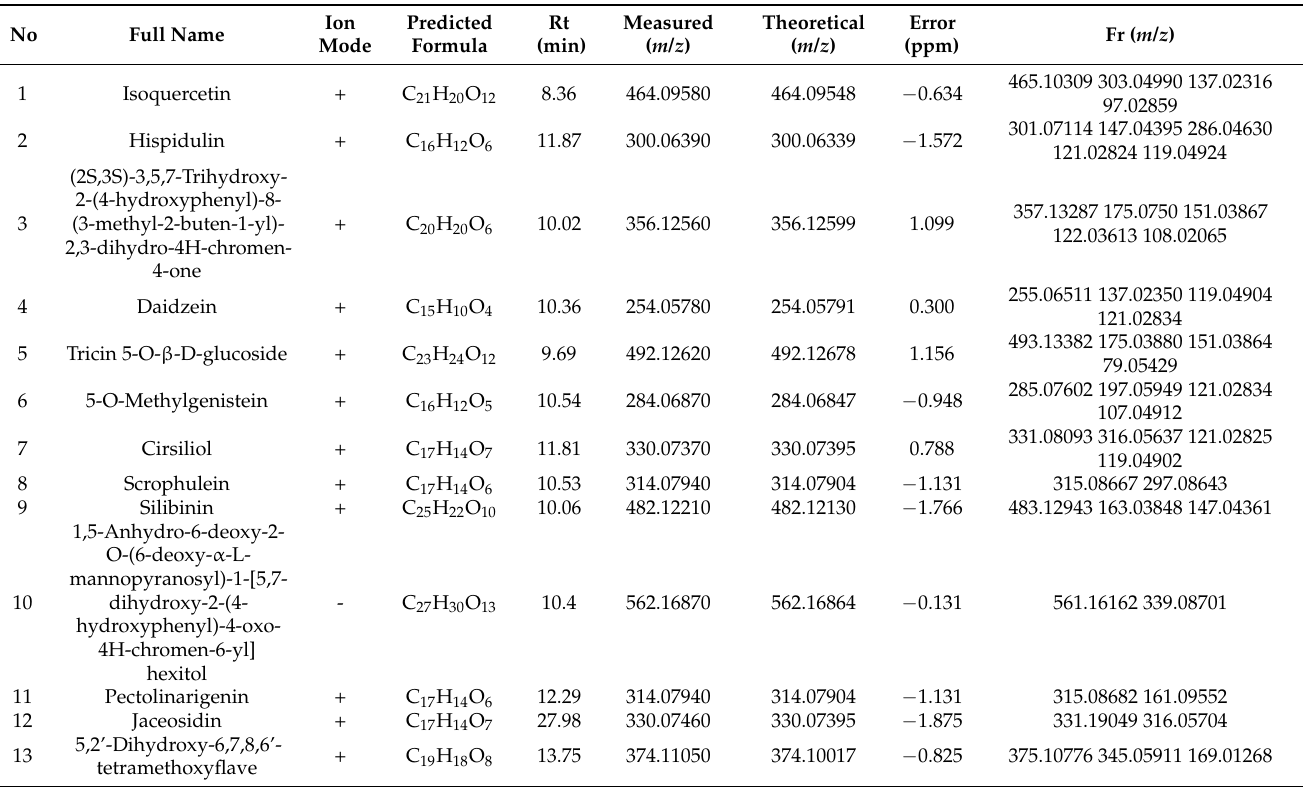
Table 5. UHPLC-HRMS/MS data of flavonoids in